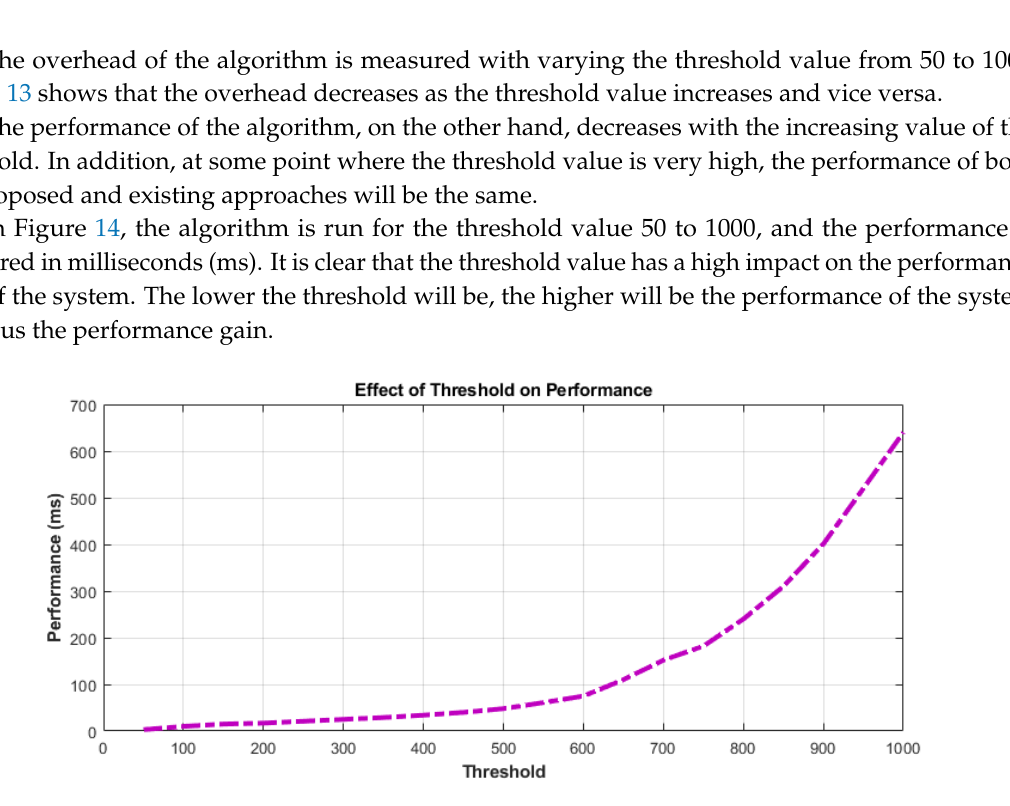
Figure 13. Overhead vs. Threshold.